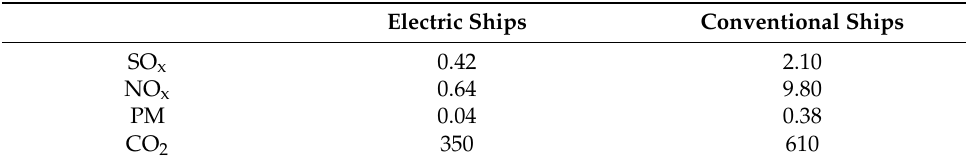
Table 7. Emission factors of electricity and conventional ships (gram/kWh).